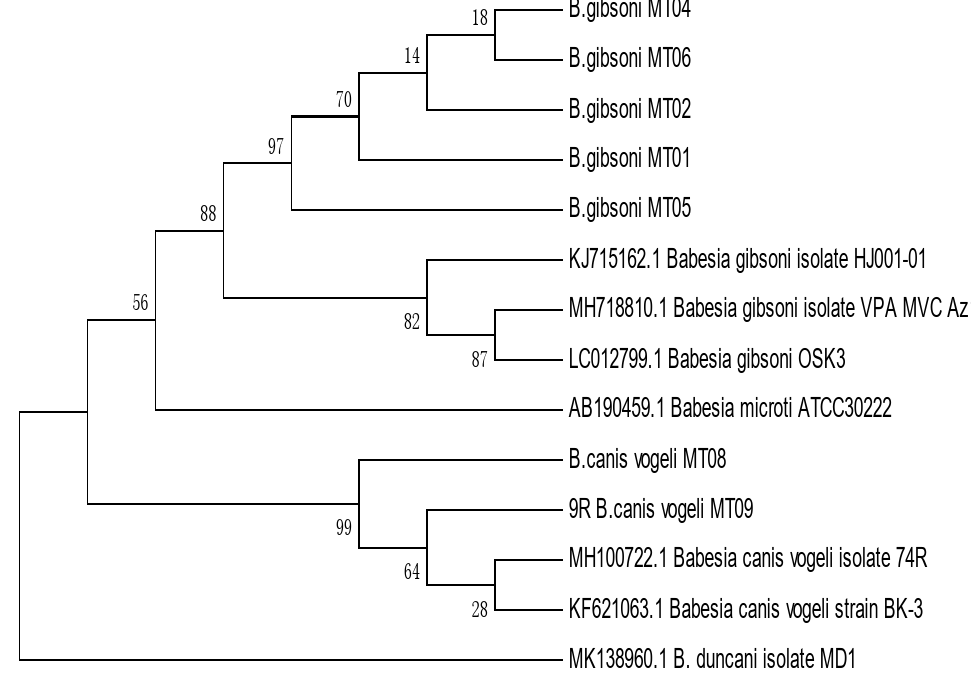
Figure 3. Genetic relationships of Babesia canis and B. gibsoni isolates from Pakistan with reference selected from previous studies.